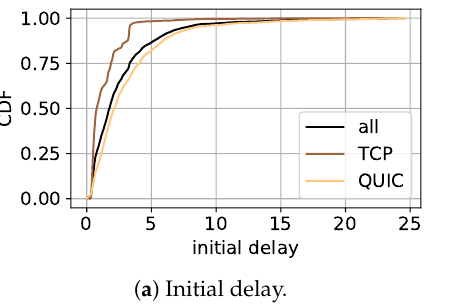
Figure A2. Dataset overview: initial delay and downlink